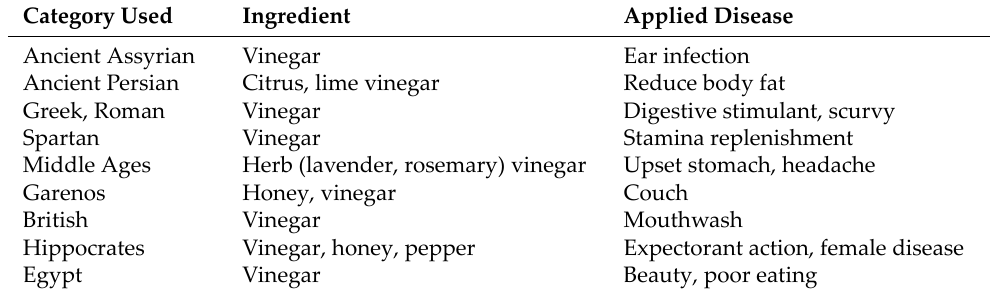
Table 2. Medicinal usage of vinegar.